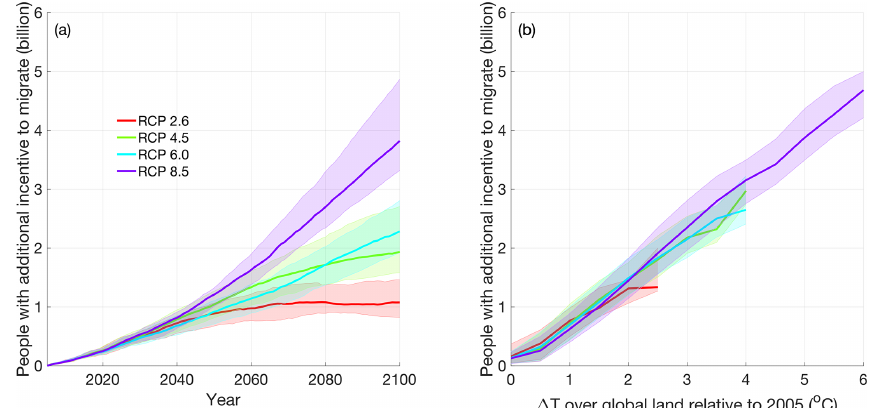
Figure 3. (a) The number of people projected to experience additional climate-related incentive to emigrate under four Representative Concentration Pathways (RCPs) against years, and (b) the number of people projected to experience additional climate-related incentive to emigrate against the change in the 30-year moving mean temperature over global land relative to 2005. The lines show the median value across CMIP5 models with results from 66% of the models falling within the shaded area. The results hold all factors constant, except for climate and country-level